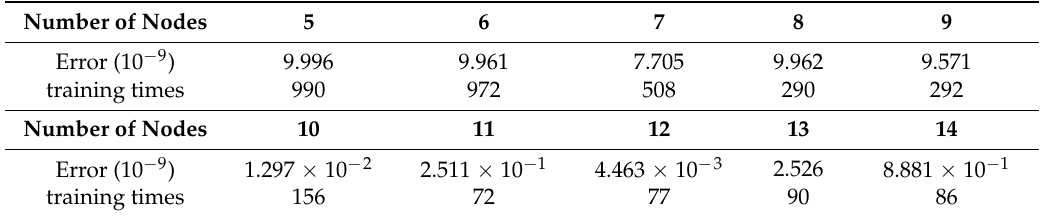
Table 3. Training error and times of BP neural network (in different numbers of nodes for the hidden layer). Number of Nodes